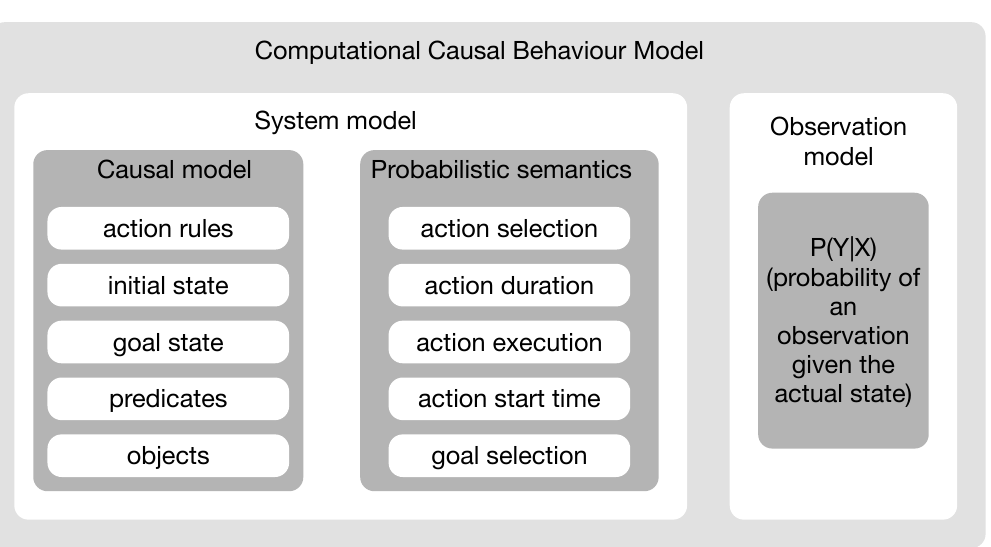
Figure 2. Elements of a Computational Causal Behaviour Model